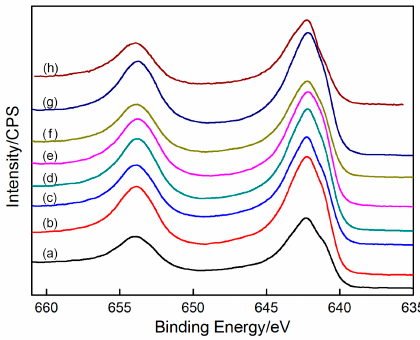
Figure 14. Mn 2p spectra of MnO 2 deposited for different times: ( a ) 2 s; ( b ) 5 s; ( c ) 8 s; ( d ) 9 s; ( e ) 20 s; ( f ) 30 s; ( g ) 40 s; ( h ) 60 s.